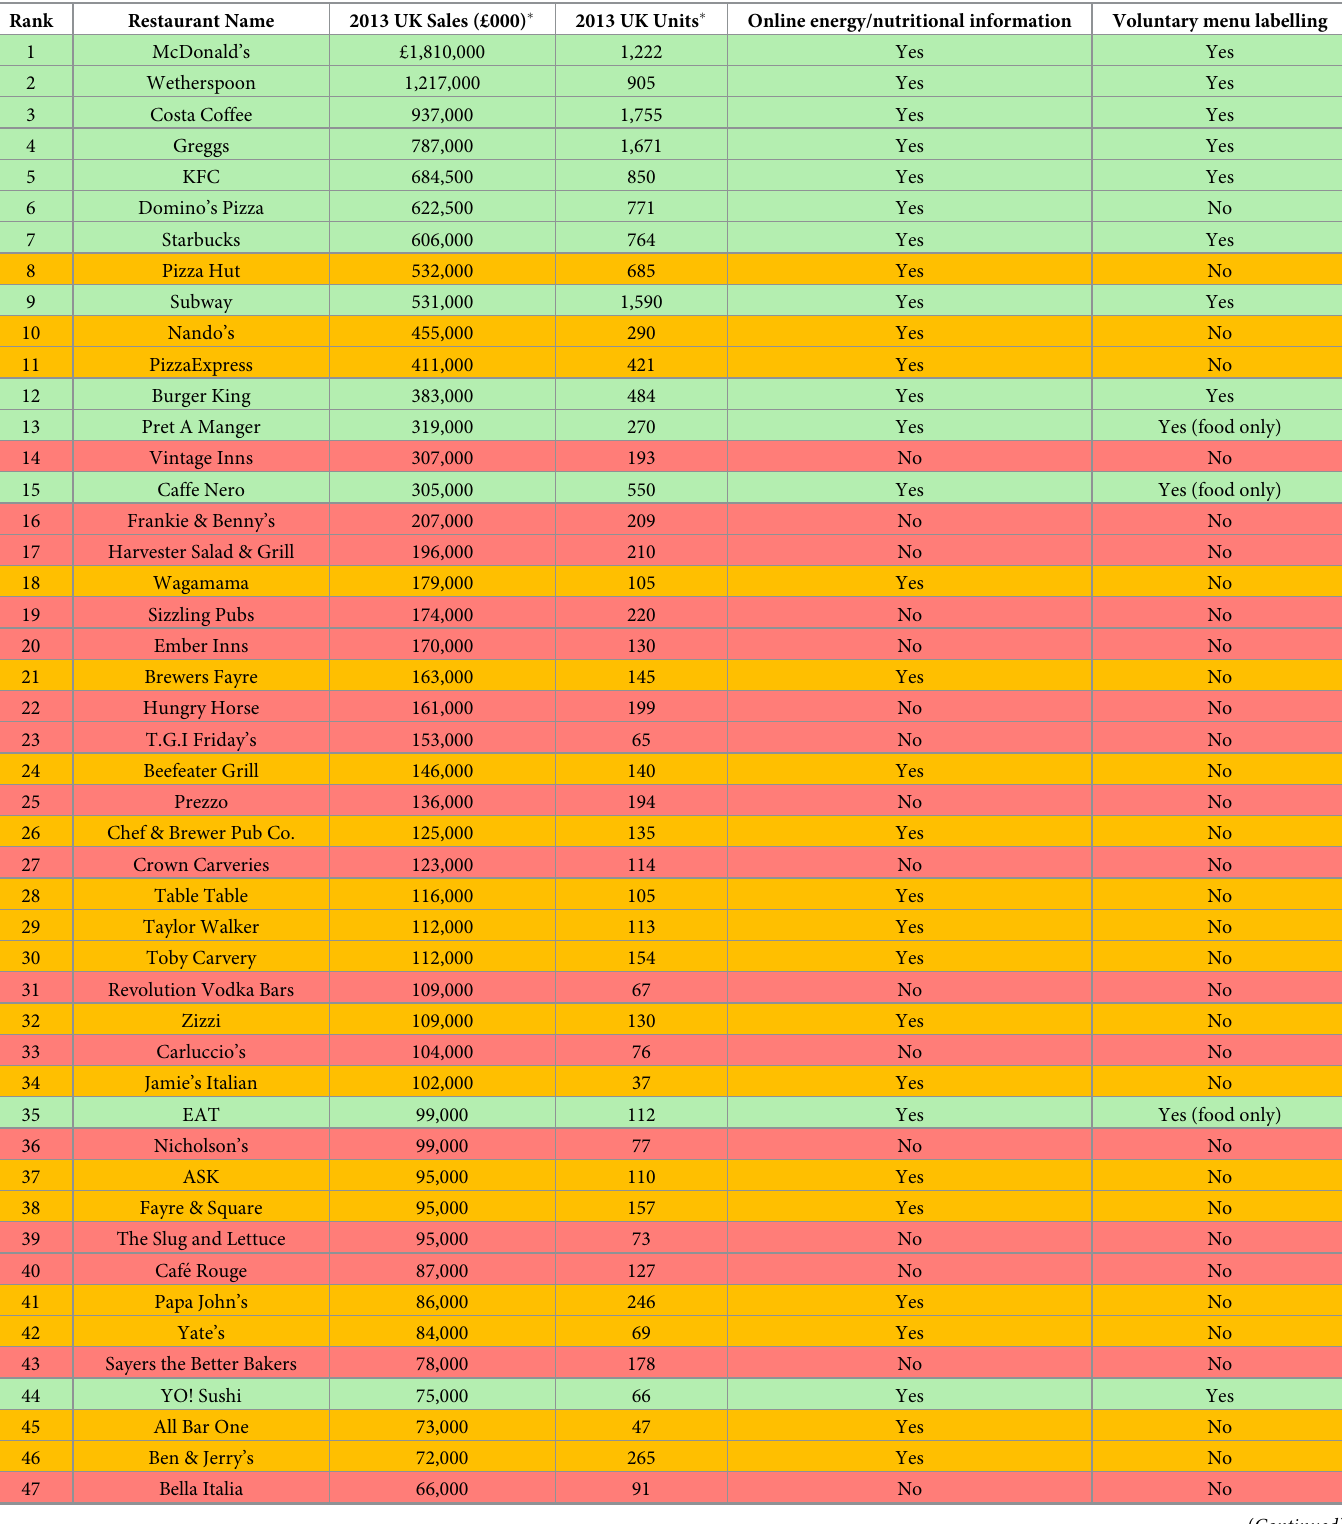
Table 2. Total UK sales and UK units in 2013, presence of online nutritional information, and voluntary menu labelling in 100 popular UK chain